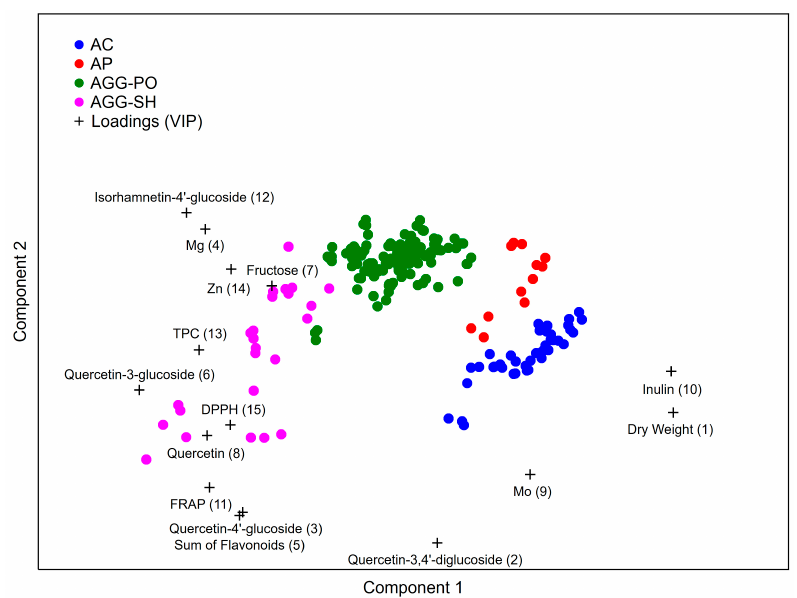
Figure 1. Discrimination of shallot species based on their phytochemical profiles using the PLS-DA model. AC— A. × cornutum ; AP— A. × proliferum ; AGG-PO— A. cepa Aggregatum potato onion type; AGG-SH— A. cepa Aggregatum shallot type.